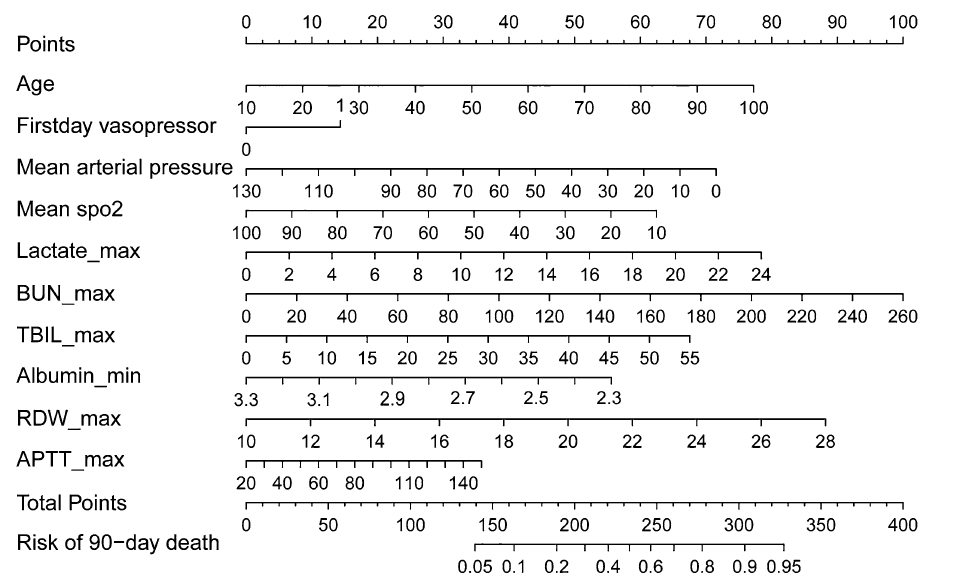
Figure 3. Nomogram for estimating the risk of 90-day mortality in SALI patients. By developing the scale score, the change in each variable is described by the forest plot, and then the total score is computed to predict the possibility that an event will